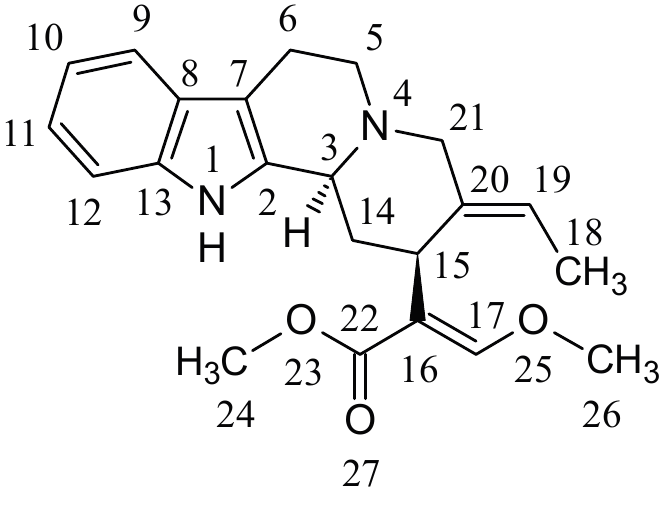
Figure 1. Chemical structure of